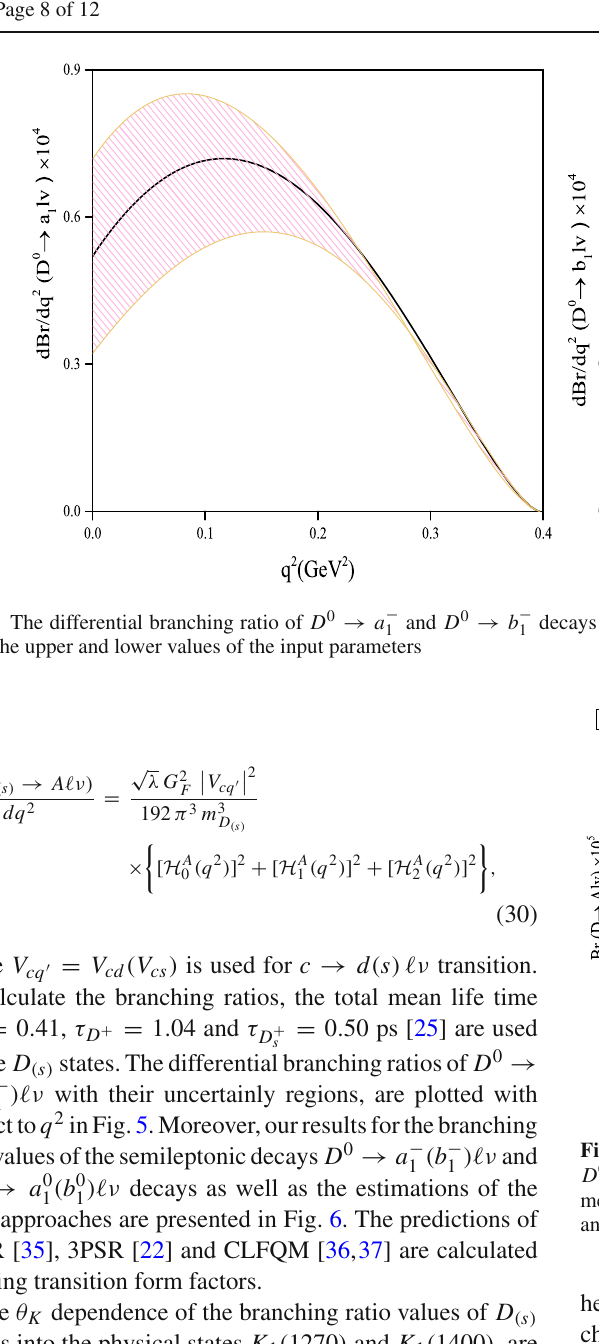
helicity form factors come from the borel parameter M 2 , the charm quark mass m c and (cid:18) ⊥ twist-2 light cone distribution amplitude of the axial vector meson. To extend the LCSR cal- culations to the full physical region, the extrapolated series expansions are used and the low-lying D meson resonances with 1 + and 1 − quantum numbers were utilized as the dom- inant poles. Based on the fitted form factors, predictions for the branching ratios of relevant semileptonic decays were